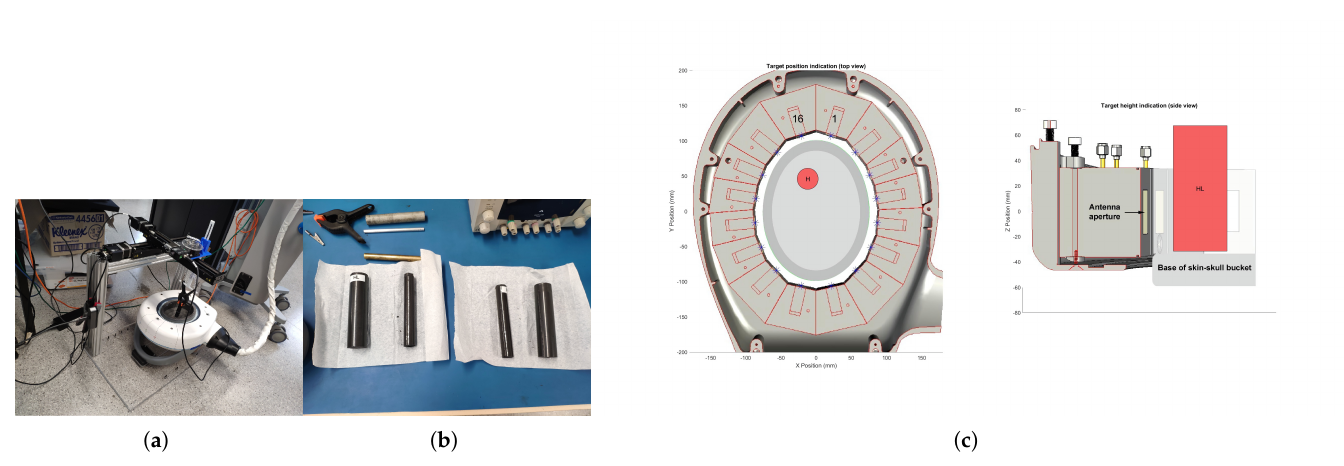
Figure 1. ( a ) Anthropomorphic head model within the array imaging domain upside-down, filled with average brain-emulating liquid. ( b ) solid cylinders HL, HM, IM, and IL from left to right. ( c ) An example of a ground truth image of an HL target positioned close to the periphery of the head phantom. Table 1. The specifications of 608 brain stroke targets used in